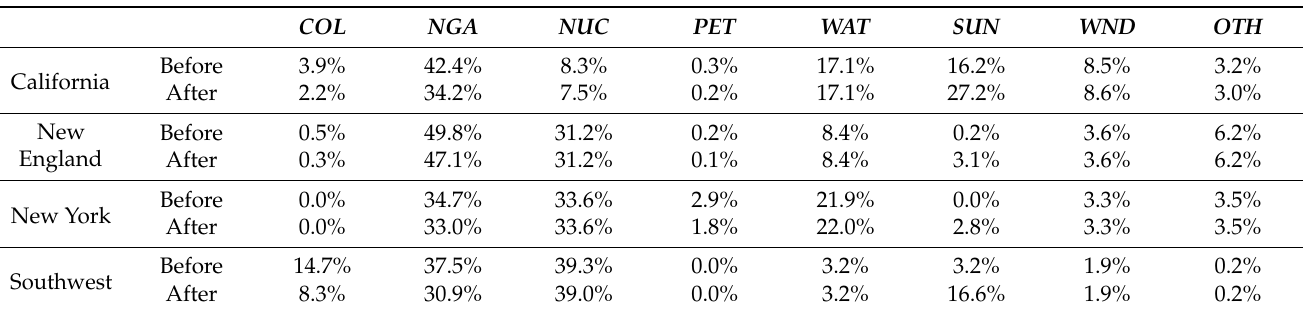
Table 4. 75% solar penetration—Generation by region and sources before and after adding the hypothetical solar plants. COL NGA NUC PET WAT SUN WND OTH